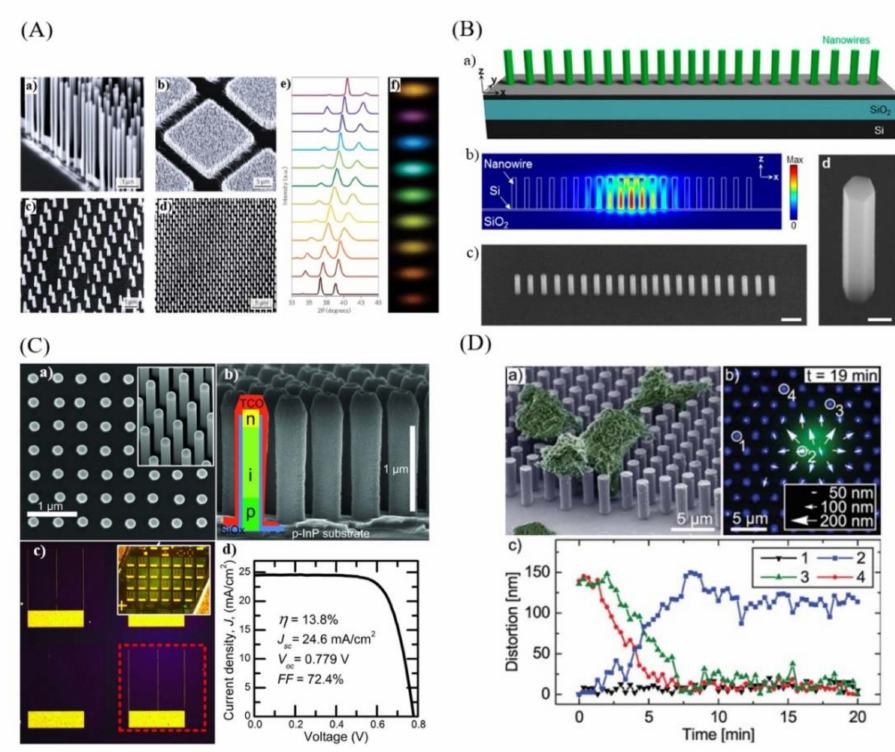
Figure 1. ( A ) Scanning-electron microscope images of different vertically aligned semiconductor nanowire arrays (ZnO NWs (a), GaN NWs (b), InP NW (c), InAs/InP heterostructured NWs (d)), (e) X-ray diffraction for InGaN nanowires arrays with different In concentrations, (f) CCD camera image of the visible photoluminescence emission of In x Ga 1 − x N nanowire (x = 0–0.6) (reprinted with permission of Refs. [20,76–78]); ( B ) InGaAs/InGaP core/shell nanowires array laser monolithically integrated on SOI: (a) Schematic of the nanowire array laser, (b) Electric field profile (|E|) of the fundamental cavity mode, (c) Tilted SEM images of the nanowire array laser and (d) individual NW (reprinted with permission of Ref. [19]); ( C ) InP nanowire array solar cells: (a) top-view and 30 ◦ tilt scanning electron micrographs of as-grown NWs, (b) SEM images of processed nanowires with a schematic of the individual devices, (c) optical microscope images of the solar cells, (d) solar cell I-V characteristics (reprinted with permission of Ref. [16]); ( D ) NWs array based nanomechanical biosensor for living cells induced forces detection: (a) scanning electron micrograph of the cells immobilized on the array, (b) fluorescence of the cell and reflection of the nanowire array, (c) distortion analysis as a function of time. (Reprinted with permission of Ref.